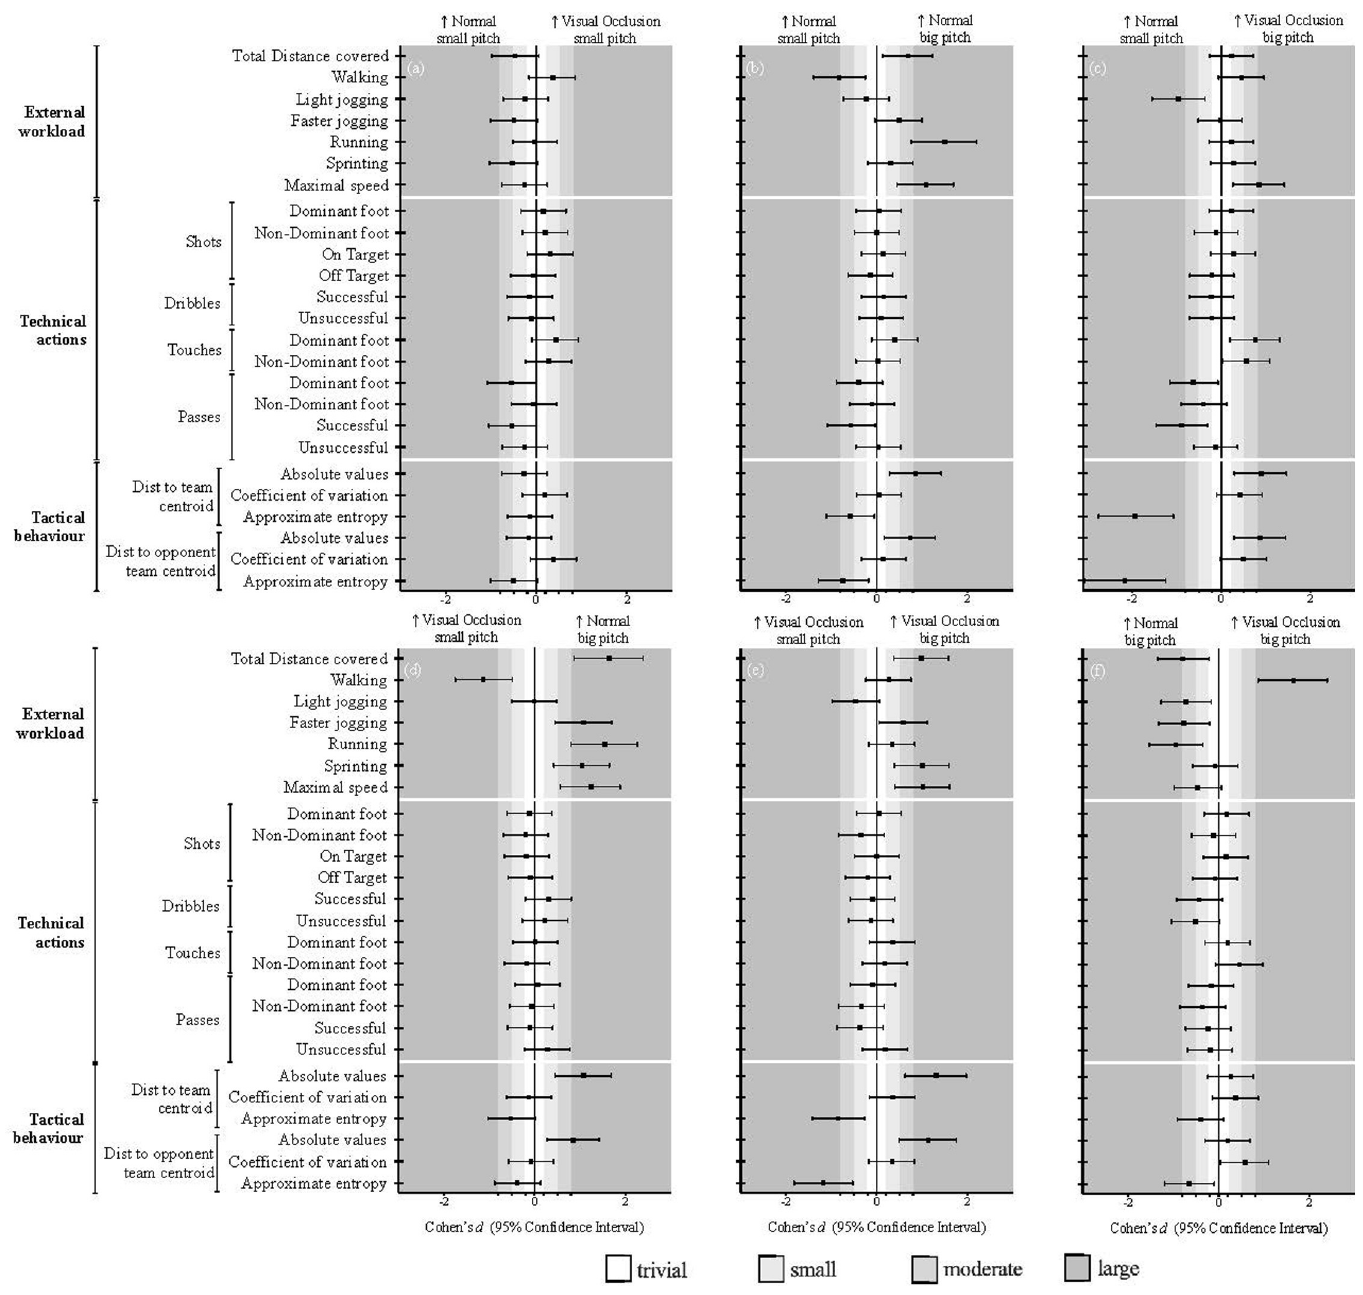
Fig 3. Standardized (Cohen) differences in the tactical behaviour, external workload and technical actions variables according to game scenarios (N vs VO) and pitch size (small vs big). Error bars indicate uncertainty in the true mean changes with 95% confidence intervals.